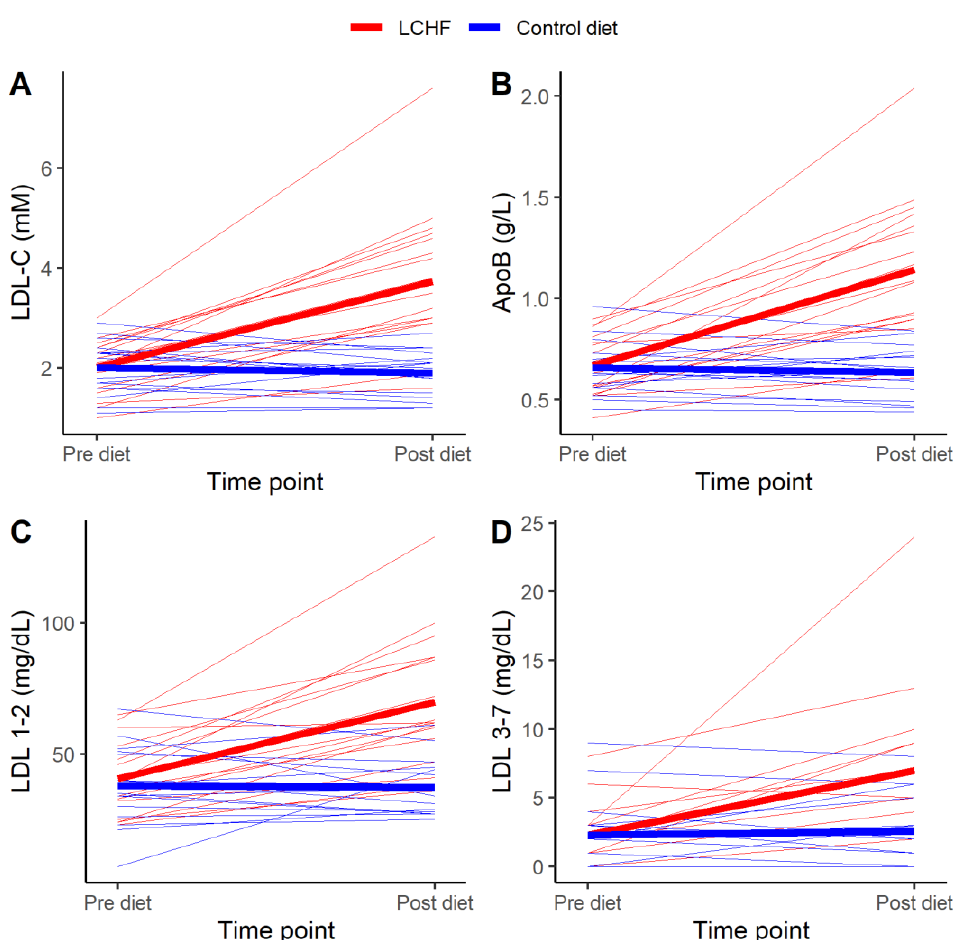
Figure 2. Individual ( n = 17) changes of ( A ) low-density lipoprotein cholesterol (LDL-C), ( B ) Apolipoprotein B-100 (ApoB), ( C ) large, buoyant LDL (LDL 1–2), and ( D ) small, dense LDL (LDL 3–7). Pre diet (i.e., immediately before diet intervention) and Post diet (after four week diet intervention). The ketogenic low carbohydrate high fat diet (LCHF) is indicated with red lines, and the Control diet is indicated with blue lines. Thick lines represent mean values for the respective diets.